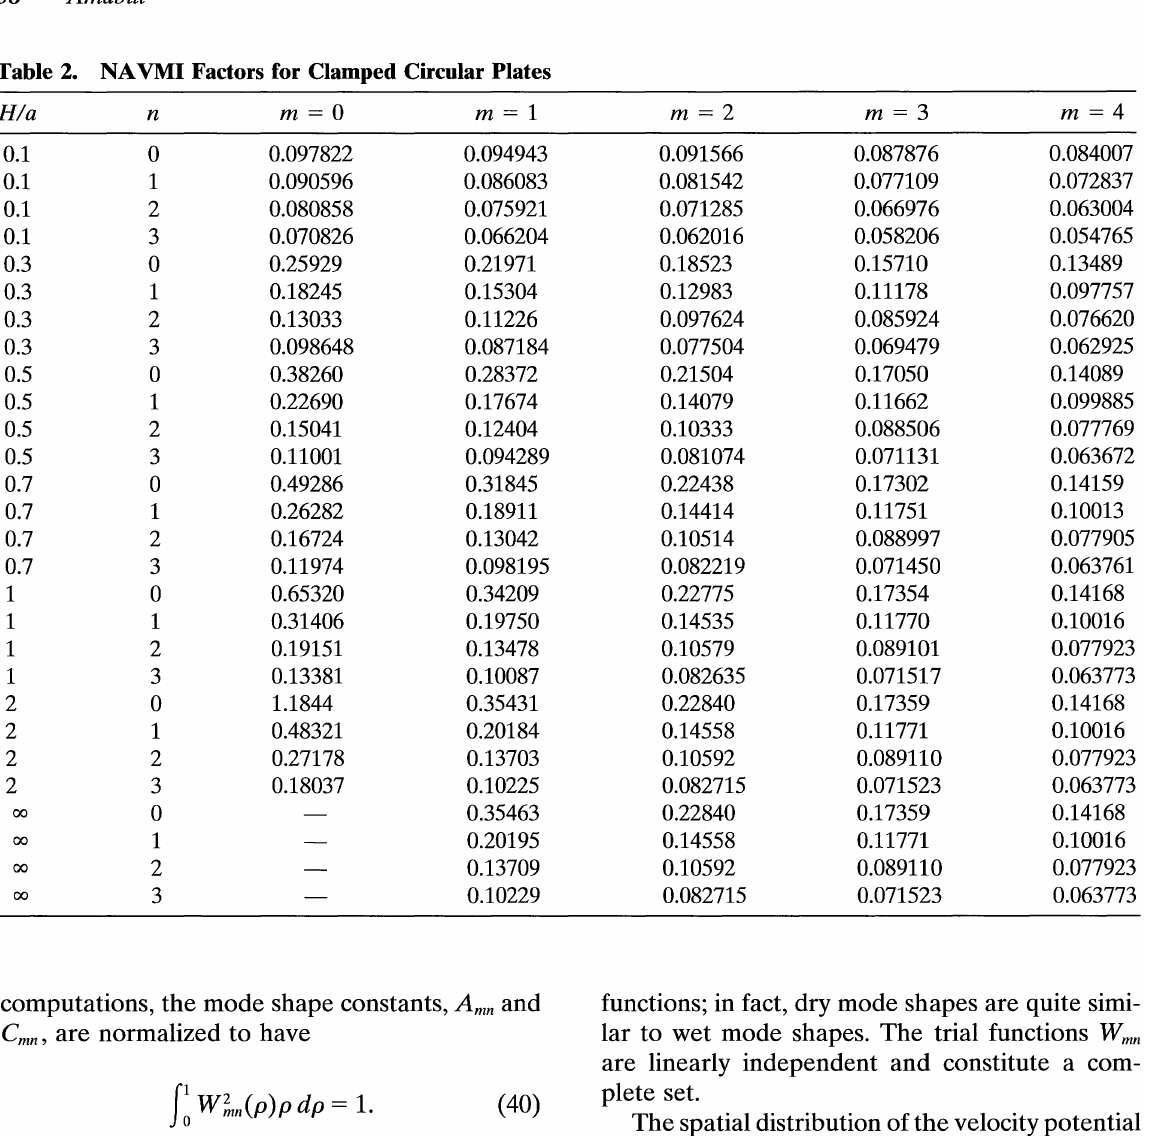
Table 2. NA VMI Factors for Clamped Circular